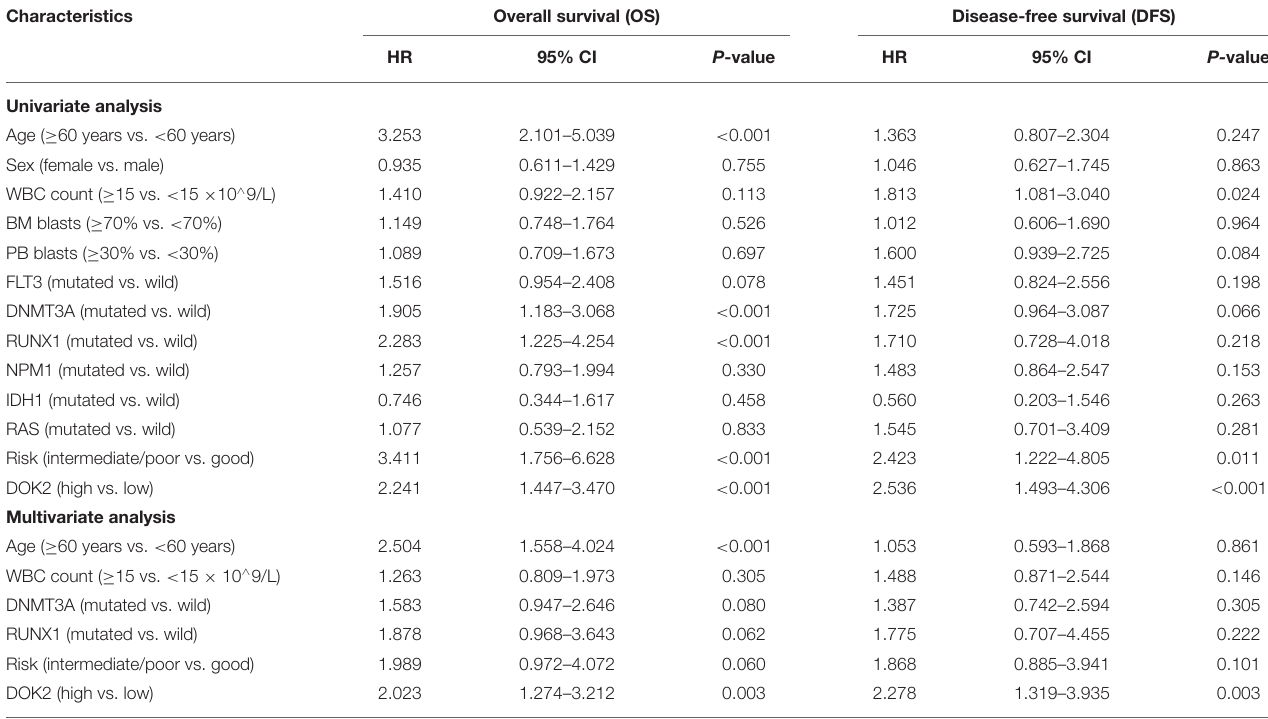
TABLE 2 | Univariate and multivariate Cox regression analysis for OS and